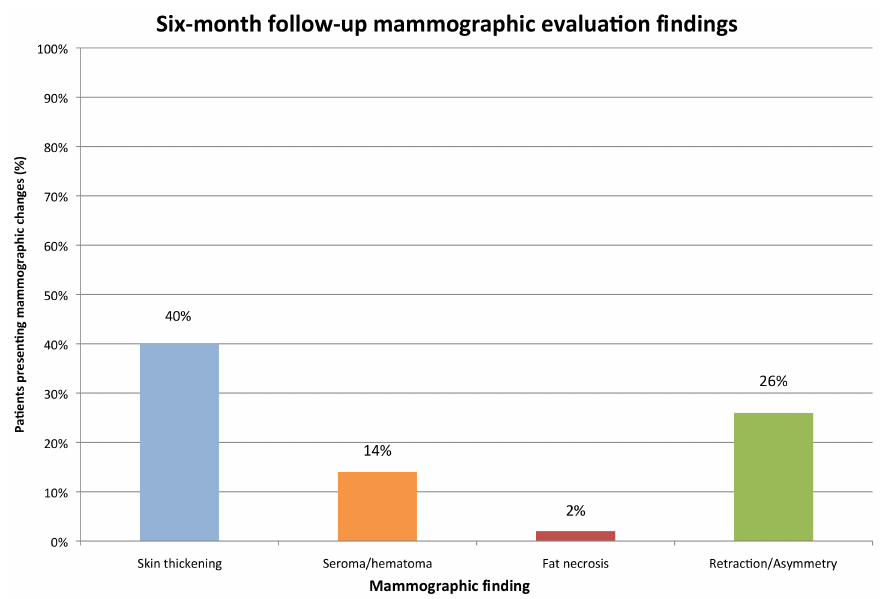
Figure 6. Six-month follow-up mammographic evaluation